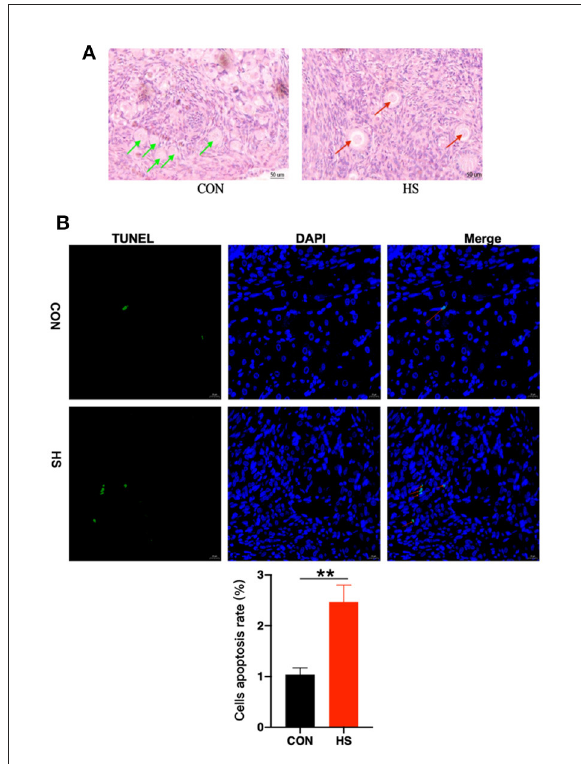
FIGURE3 (A) Ovarian histomorphology ( n = 3 per group) in HS group and CON group. Green arrows indicated normal primary follicles and red arrows indicated vacuolated primary follicles; (B) Apoptotic cell count and cells apoptosis rate in ovarian tissues ( n = 3 per group) in HS group and CON group. Nuclei were stained with blue dye (DAPI). Furthermore, red arrows indicated TUNEL-positive cells (green, Bar = 20 µ m). Cells apoptosis rate = TUNEL positive cells/DAPI cells. ** indicated statistically significant difference.